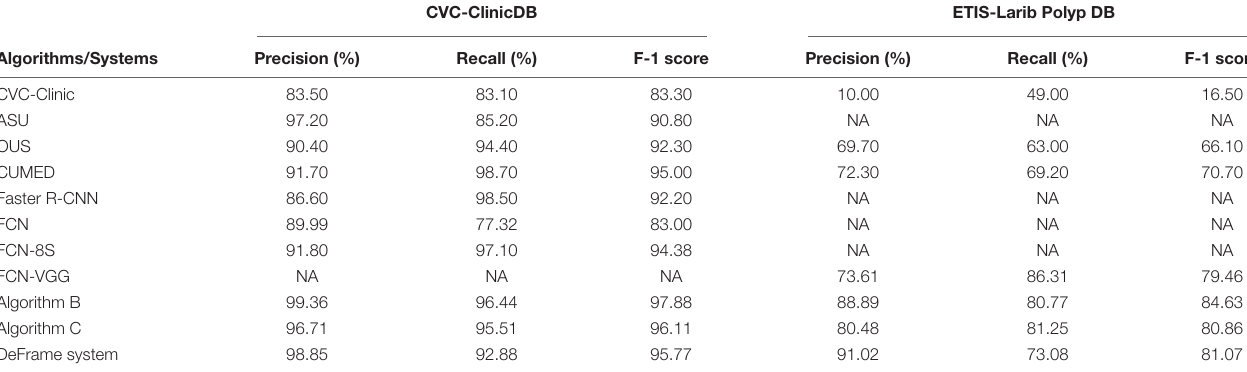
TABLE 2 | Performance comparison of different polyp detection algorithms and systems on two public datasets.